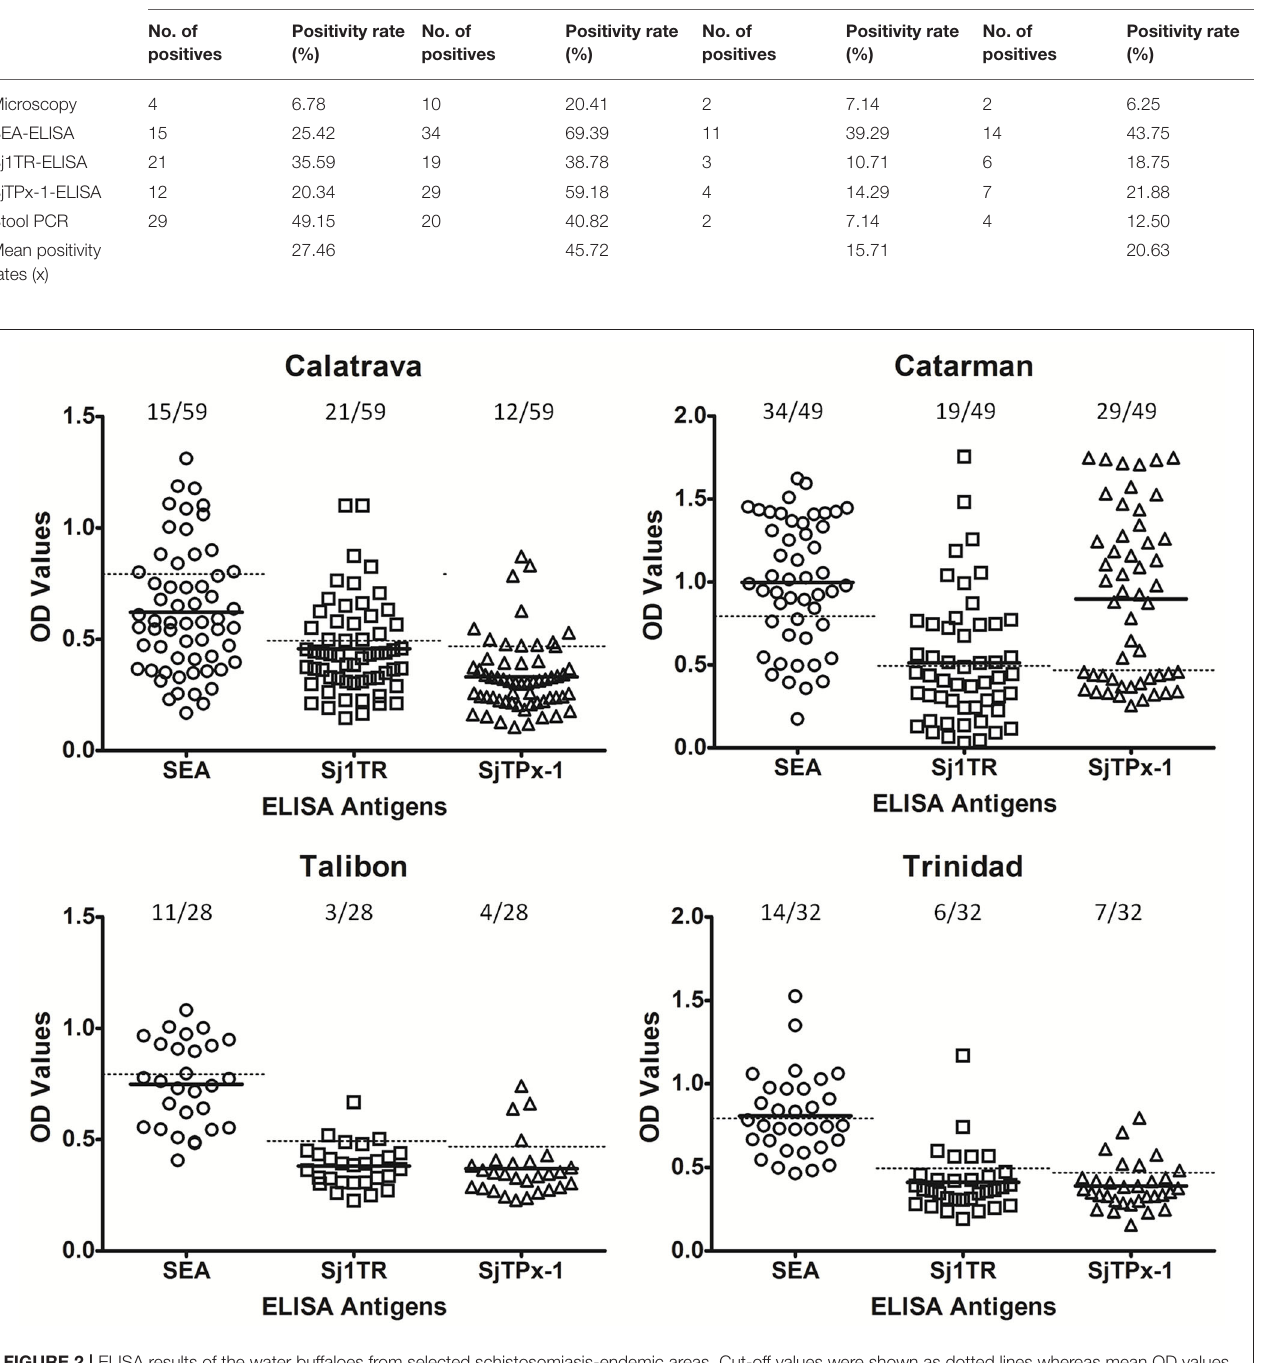
FIGURE 2 | ELISA results of the water buffaloes from selected schistosomiasis-endemic areas. Cut-off values were shown as dotted lines whereas mean OD values as solid